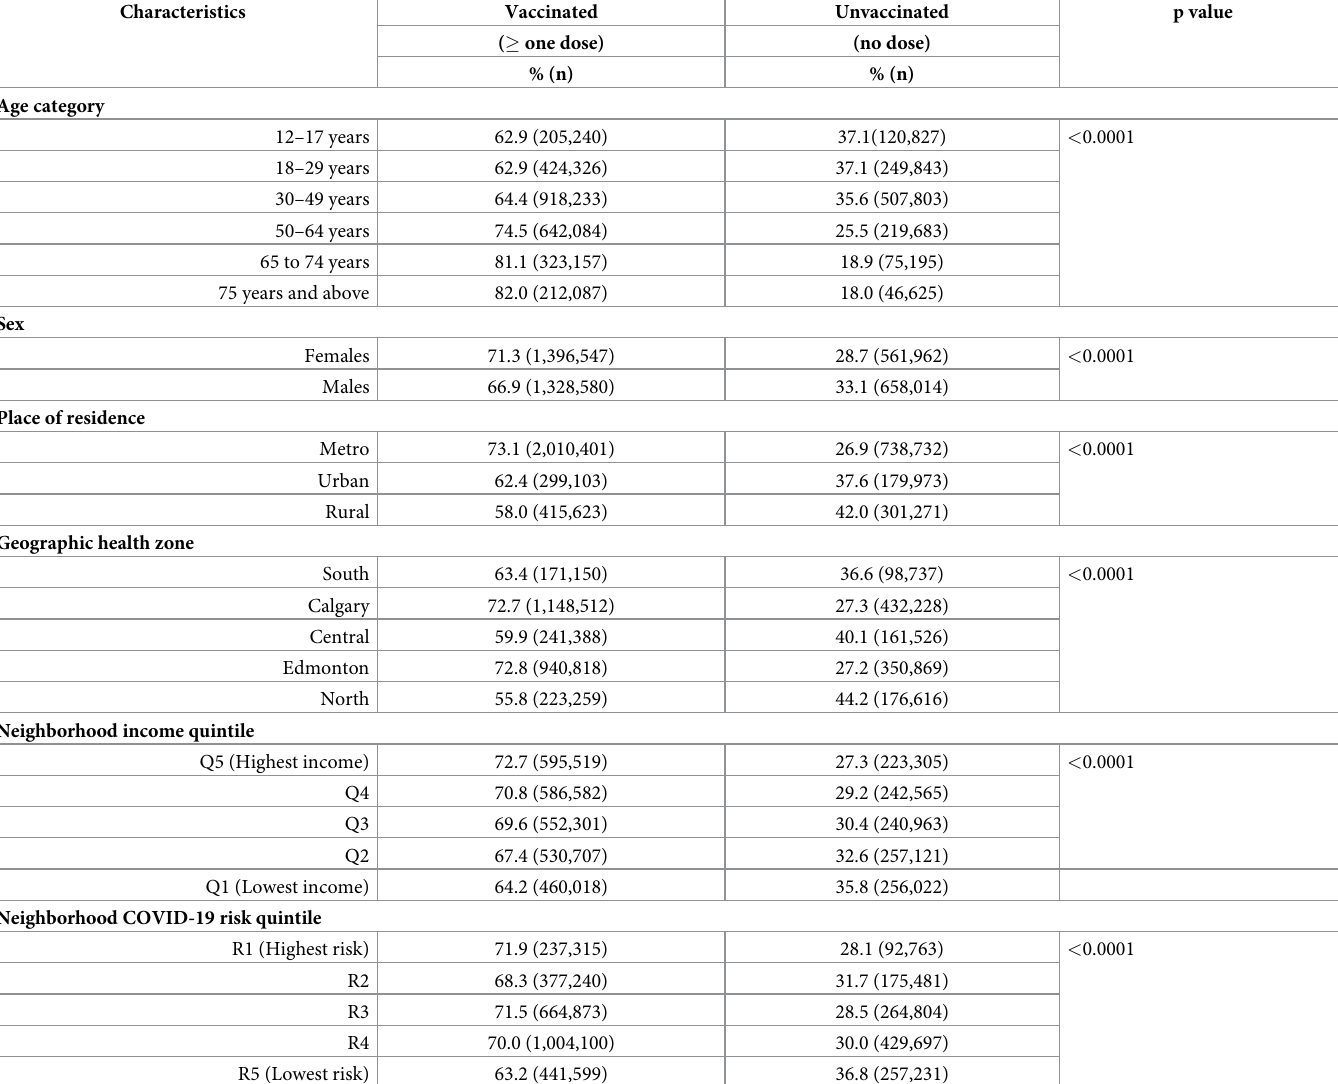
Table 1. COVID-19 vaccination coverage by individual and place-based characteristics, as of August 31, 2021, in Alberta, Canada (N = 3,945,103).